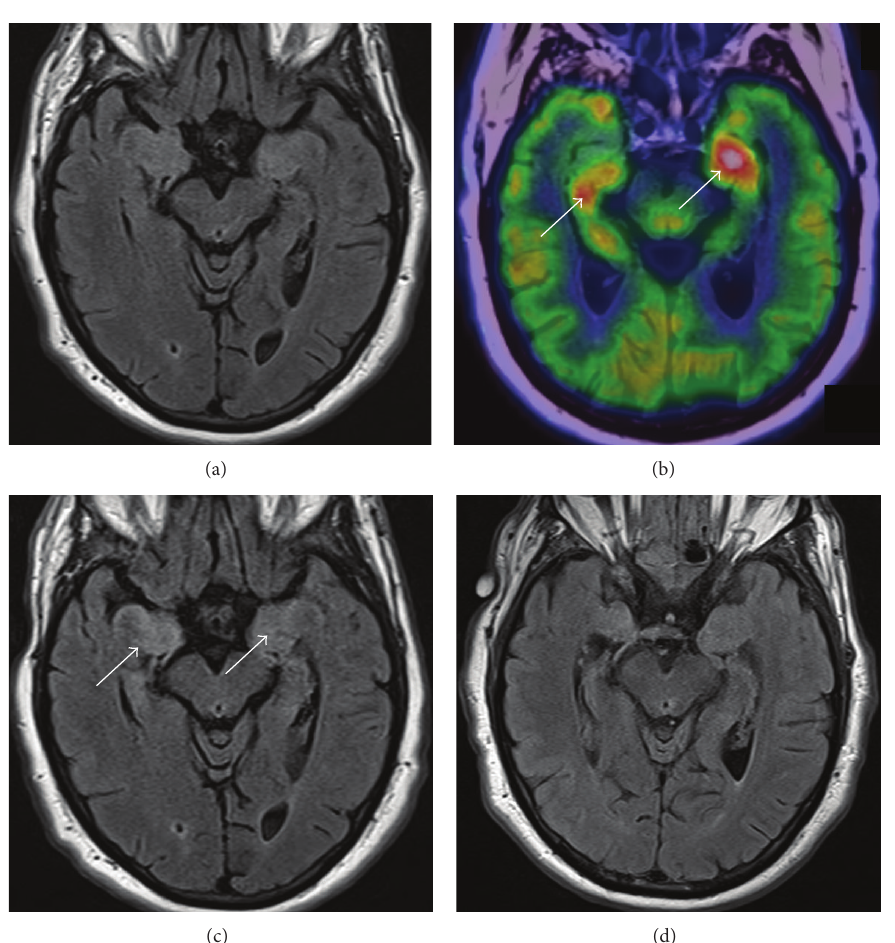
Figure 1: Neuroimaging of VGKC antibody. The initial, unremarkable axial T2/FLAIR MRI of the brain (a) followed by FDG-PET showing significant asymmetric hypermetabolism of the bilateral mesial temporal lobes (arrows; (b)) with repeat axial T2/FLAIR demonstrating hyperintensity in bilateral mesial temporal lobes (arrows; (c)) that significantly improved by the last T2/FLAIR